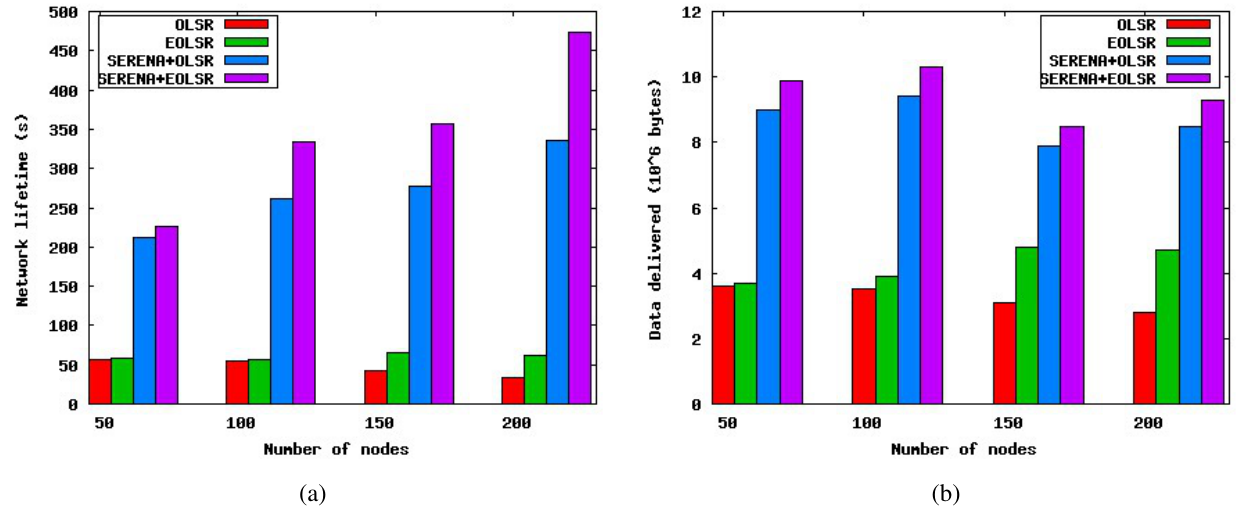
Figure 17. Comparative performances of OLSR, EOLSR, SERENA+OLSR, SERENA+EOLSR. (a) Network lifetime; (b) Amount of user data